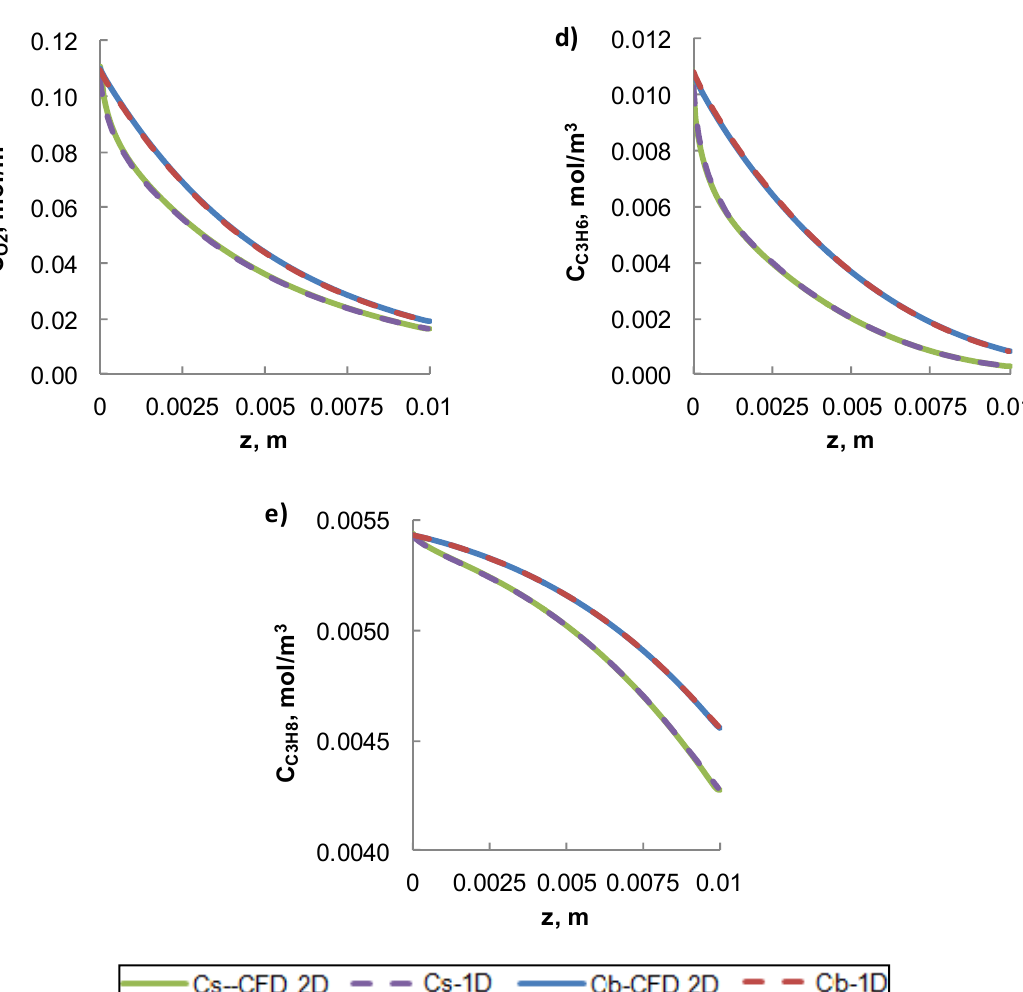
Figure 4. Concentration profiles derived from the 2-D CFD model vs the concentration profiles derived from the 1-D model combined with the 1-D correlation for mass transfer. Rich gas feed composition. Temperature 400 °C. Velocity 1.3 m/s. Re = 22.7. ( a ) CO, ( b ) NO, ( c ) O 2 , ( d ) C 3 H 6 and ( e ) C 3 H 8 .